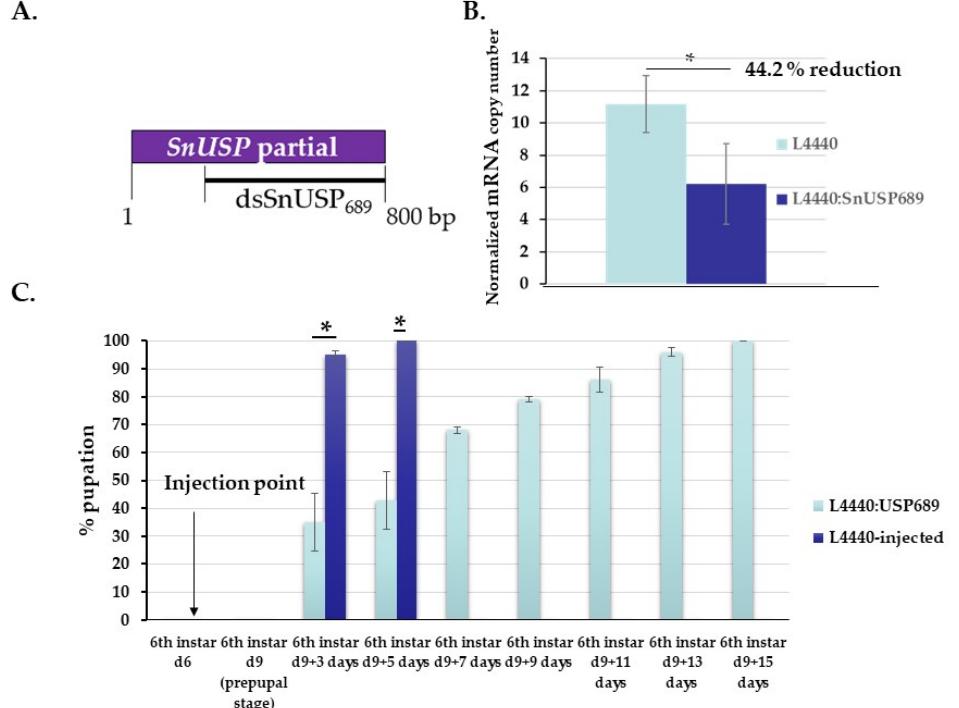
Figure 4. RNAi of USP by hemolymph injection in S. nonagrioides . ( A ). Schematic representation of the partial cDNA sequence of the S. nonagrioides ultraspiracle ( SnUSP ) gene. The bar above the sequence indicates the fragment used for the synthesis of the dsUSP 689 . ( B ). Real time RT-PCR analysis of SnUSP mRNA levels normalized against the Snb-Tub in a pool of 15 randomly selected L6d8 larvae two days post injection. Data represent ±SD of 3 biological replicates of a pool of 15 insects each × 3 technical replicates. Statistical differences are shown for USPi against control treatments using Student’s t-Test (* < 0.05). ( C ) . Pupation rate of L4440 versus L4440:USP 689 -injected animals. Statistical differences of pupation delay among L4440-injected versus L4440:USP 689 injected are shown with asterisks ( p < 0.05, Student’s t